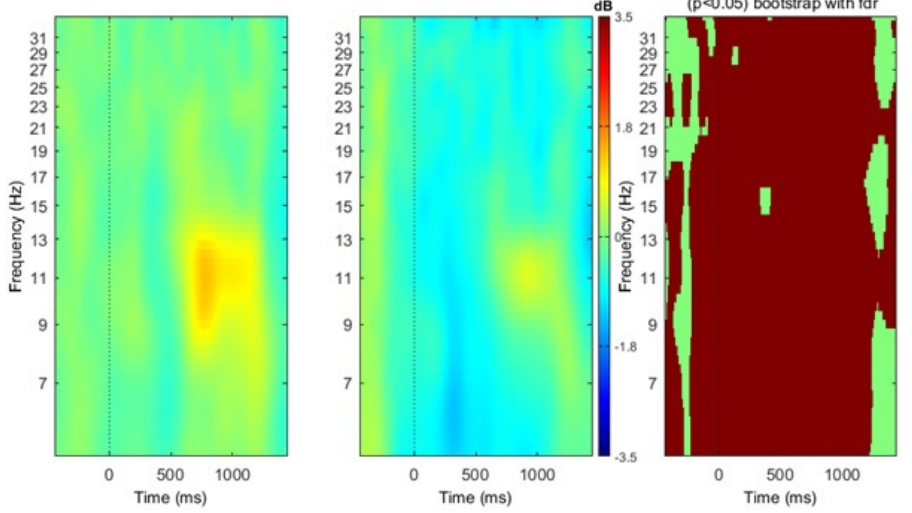
Figure 4. Right mu cluster ERSP results. The first and second panels depict ERD, indicated by blue coloring, and ERS, indicated by red coloring, across time and frequency for picture and video verb naming conditions, respectively. The third panel depicts significant difference between the conditions, indicated by red coloring, ( p FDR < 0.05) with Bonferroni corrections for false discovery rates.